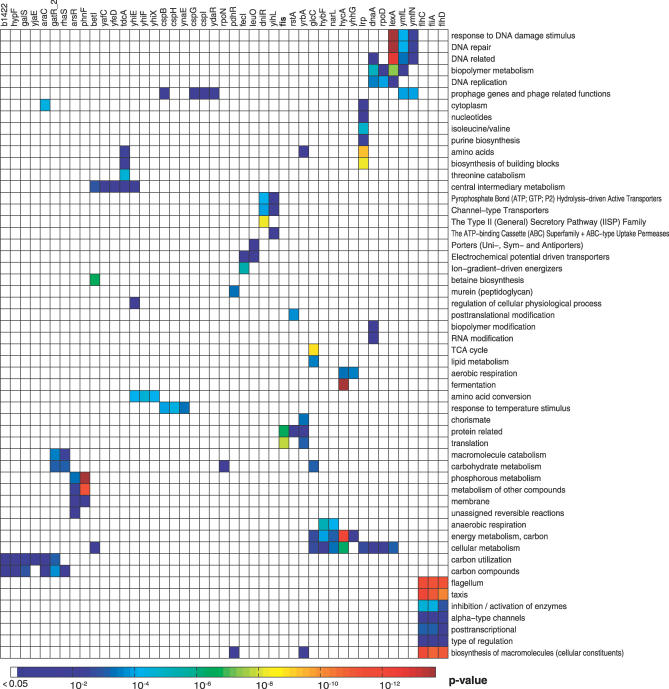
Annotation of Transcription Factor Function by Functional Enrichment Using Predicted Targets from the 60% Precise NetworkThe functional categories of the target genes of each transcription factor were tested for enrichment by a hypergeometric test. Enriched functions indicate which aspects of cellular physiology were most represented in the inferred regulatory interactions. These enriched categories also reflect the conditions sampled in the microarray compendium.